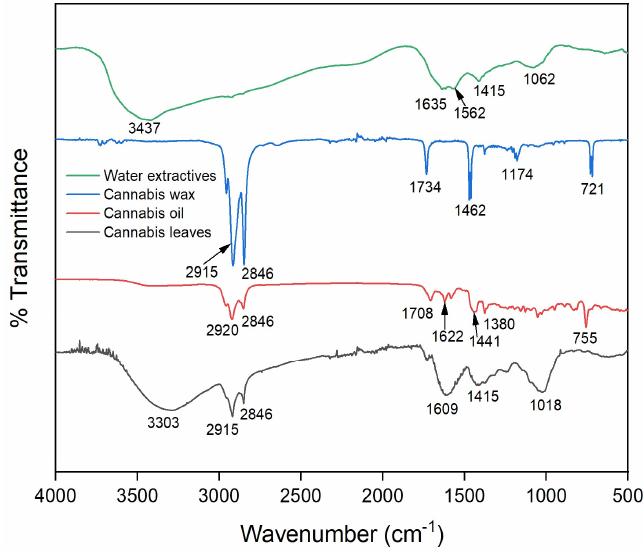
Figure 4. FTIR spectra of cannabis leaves, cannabis oil and wax obtained from SCCO 2 extraction at optimized conditions (CO 2 pressure: 250 bar, temperature: 43 °C and time: 1.7 h). Table 6. Peak assignments for FTIR spectra of cannabis leaves, oil, wax and water extractive.